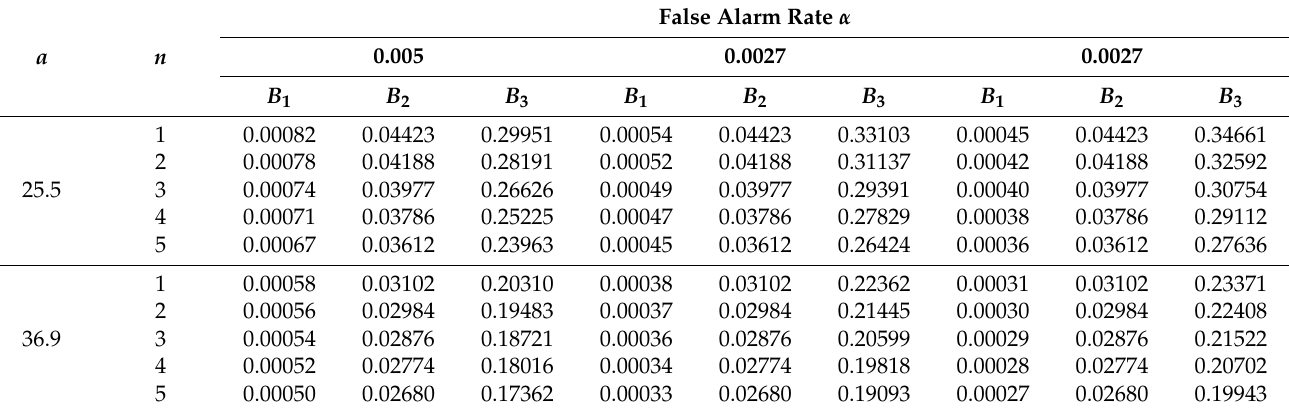
Table 2. B 1 , B 2 , and B 3 values for different n and a = 25.5,